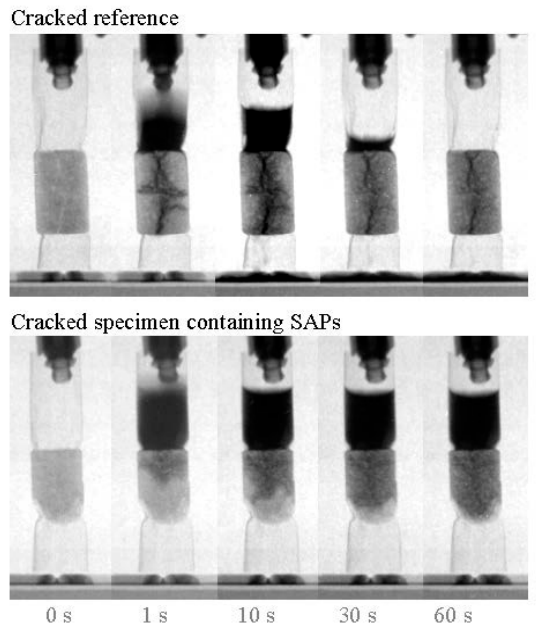
Figure 6. Decrease in water permeability in cracked mortar specimens due to the inclusion of superabsorbent polymers. Adapted from [56], with permission from © 2012 Elsevier.